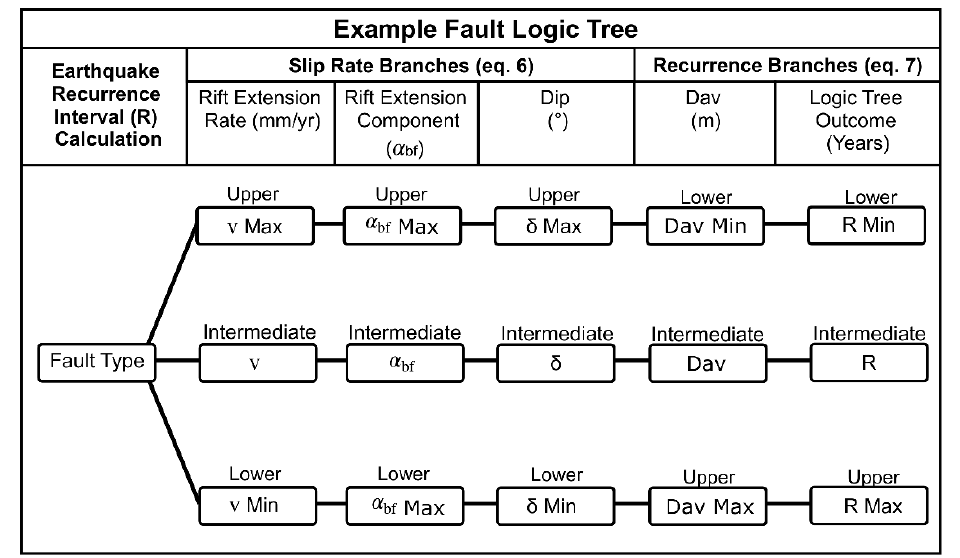
Figure 3. Logic tree used to calculate recurrence intervals for the Chipola and Molaza faults (adapted from Williams et al., 2021). Lower, intermediate, and upper estimates of fault dip, displacement, and horizontal rift extension rate are used, but we do not apply weightings to the component of rift extension rate taken up by the rift border fault ( α bf = 1) as there are insufficient constraints on the strain accommodation of border and intra-rift faults in the Luangwa